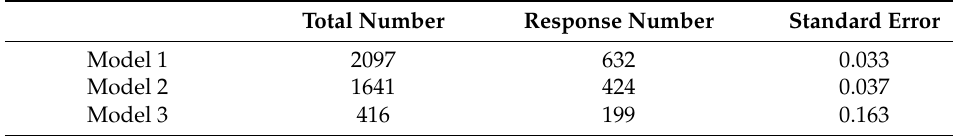
Table 3. Estimated natural response